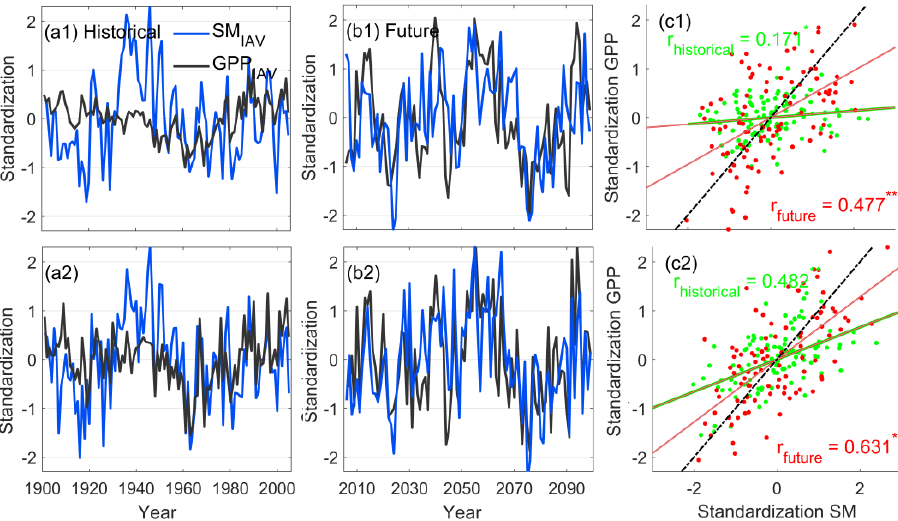
Figure 2. Standardized interannual variability characteristics of soil moisture (SM IAV ) and gross primary productivity (GPP IAV ) in Chinese grasslands. The upper side shows the annual time series, and the lower side shows the warm-season time series. ( a ) historical period; ( b ) future period; ( c ) correlation between SM IAV and GPP IAV per year, * represents passing 0.1 significance test, and ** represents passing 0.05 significance test.